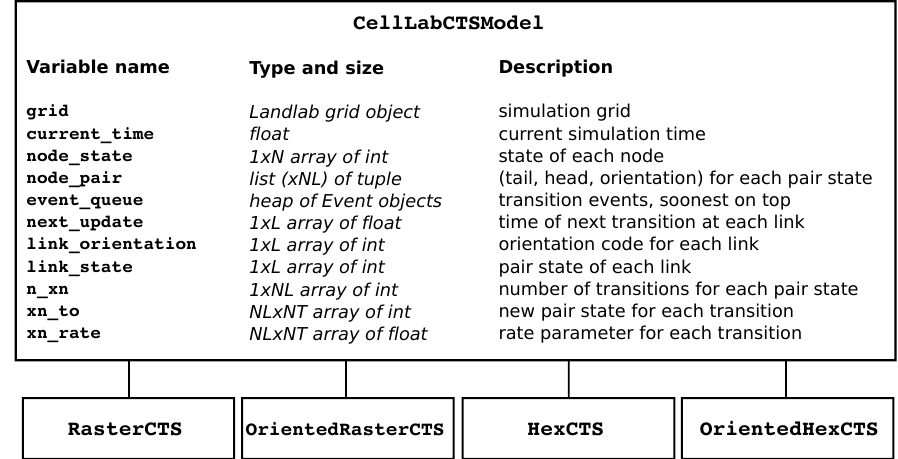
Figure 7. CellLab-CTS class hierarchy and main data structures. The base class, CellLabCTSModel, has four subclasses: RasterCTS, Ori- entedRasterCTS, HexCTS, and OrientedHexCTS. A user selects one of these four subclasses based on whether the model to be built has a hex or raster grid, and on whether pair orientation matters. N is number of grid nodes, L is number of grid links, NL is number of possible link (node pair) states, and NT is maximum number of transitions for any link